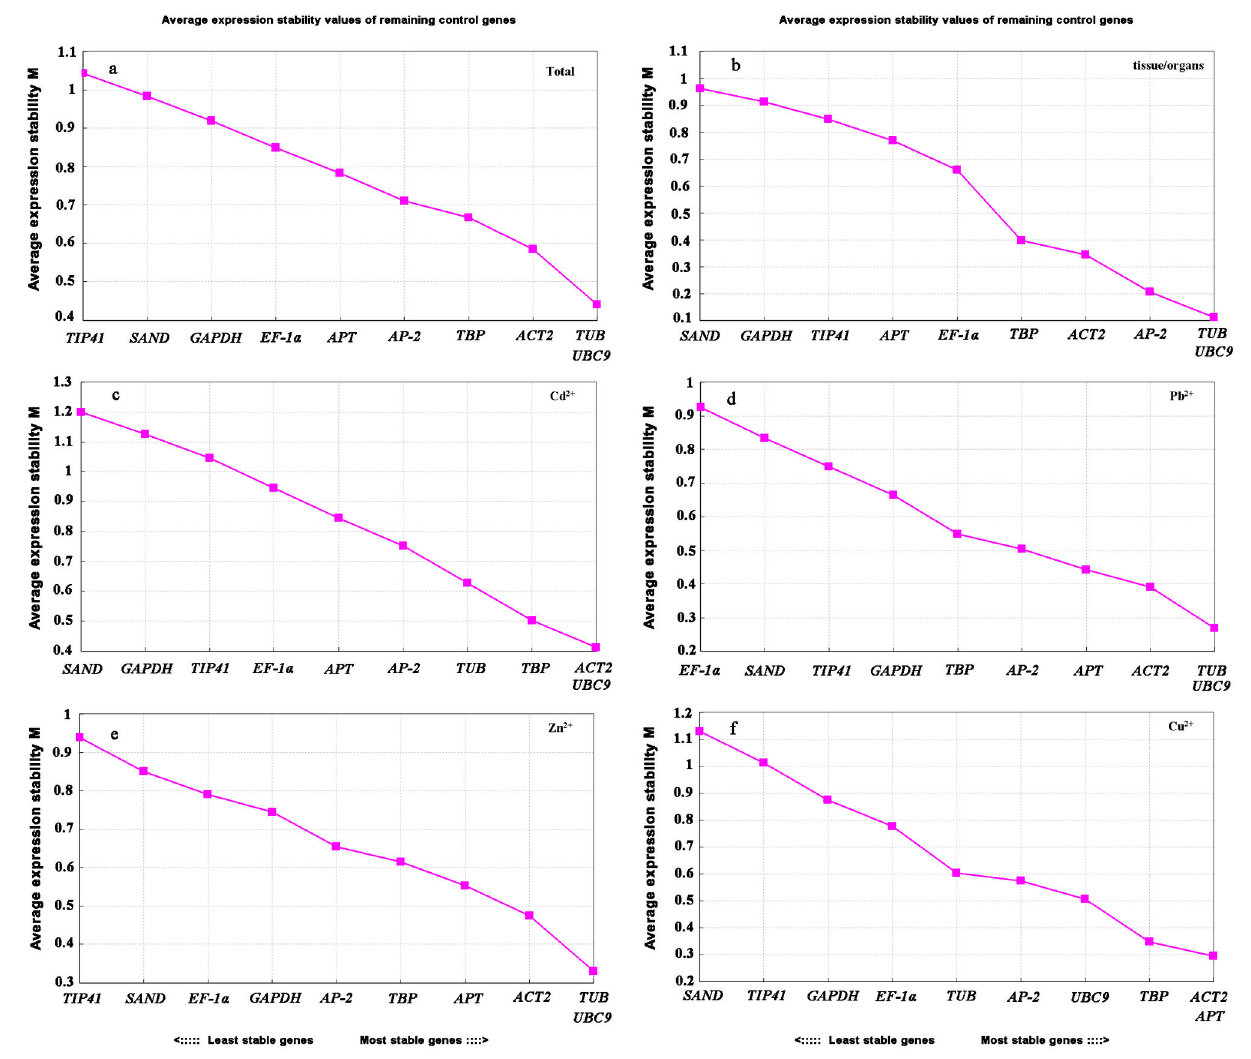
Figure 3. Expression stability ( M ) of ten reference genes across all 31 samples calculated by geNorm. (a) all 31 samples, (b) different tissue/organs, (c) Cd 2+ treatment, (d) Pb 2+ treatment, (e) Zn 2+ treatment, (f) Cu 2+ treatment. doi: